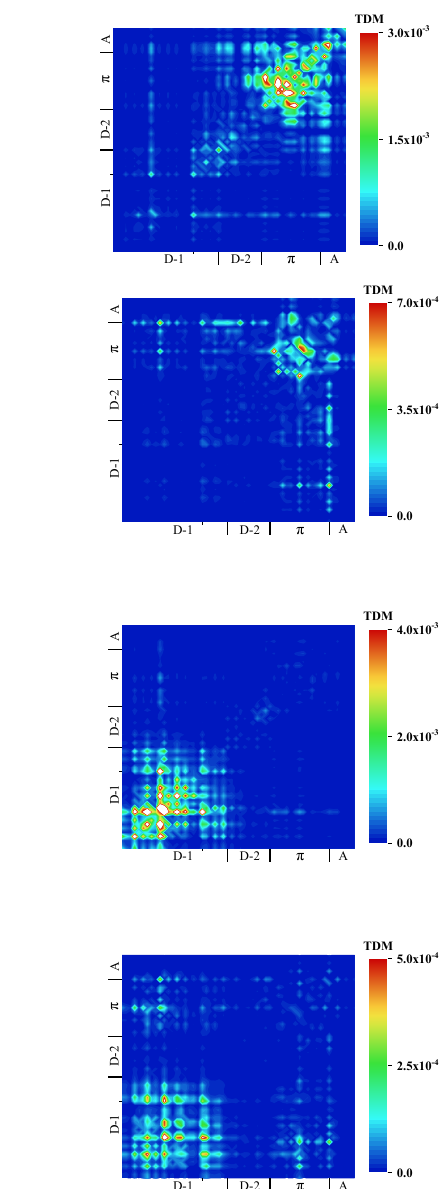
charge transfer between the π -linker and S-DTT, which was opposite to the charge trans-